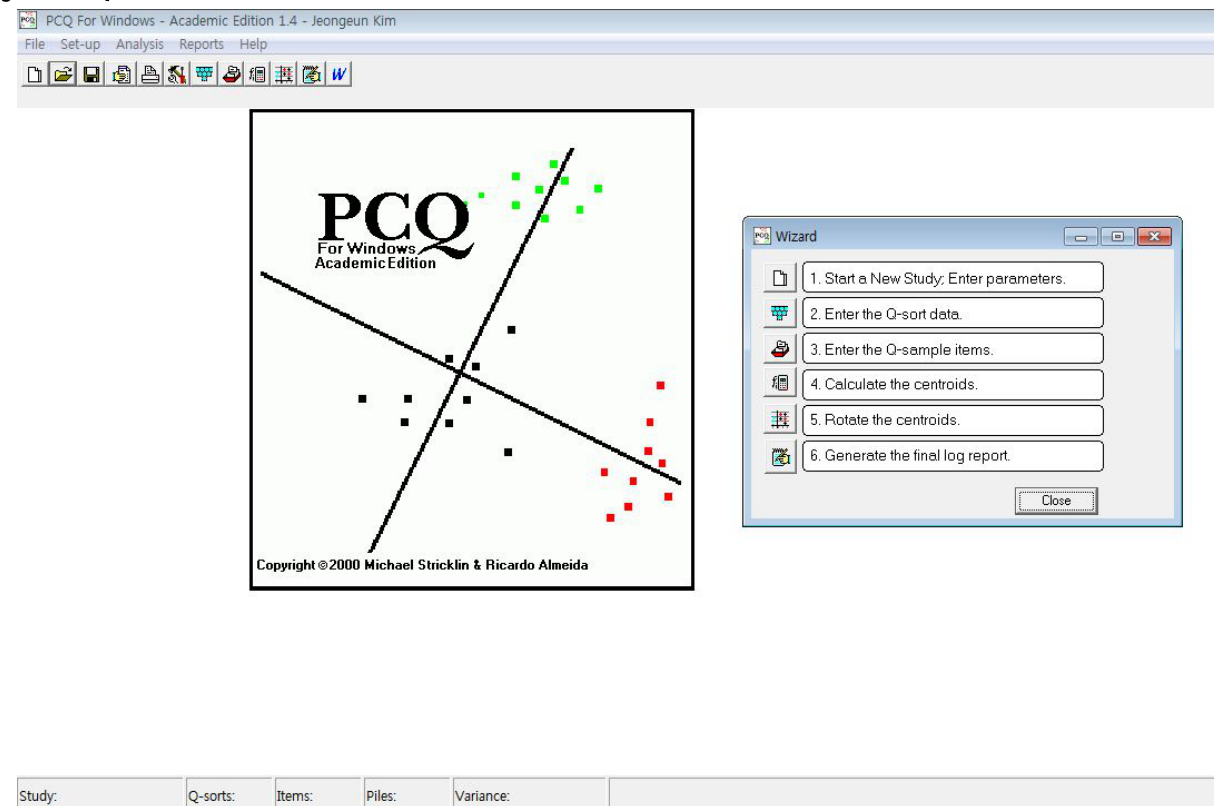
Figure 1. PCQ for